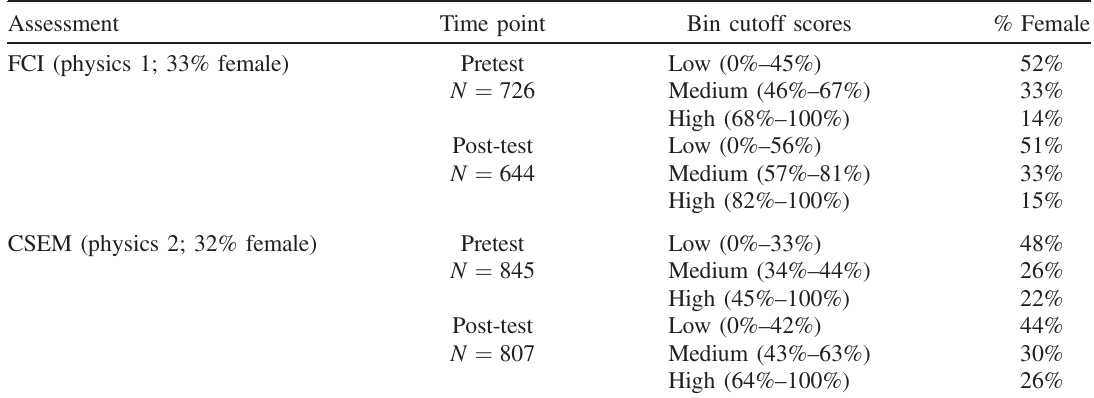
TABLE III. The cutoff scores (in assessment percentages) for each FCI pretest or post-test and CSEM pretest or post-test performance bins, along with percentage of female students within each bin.